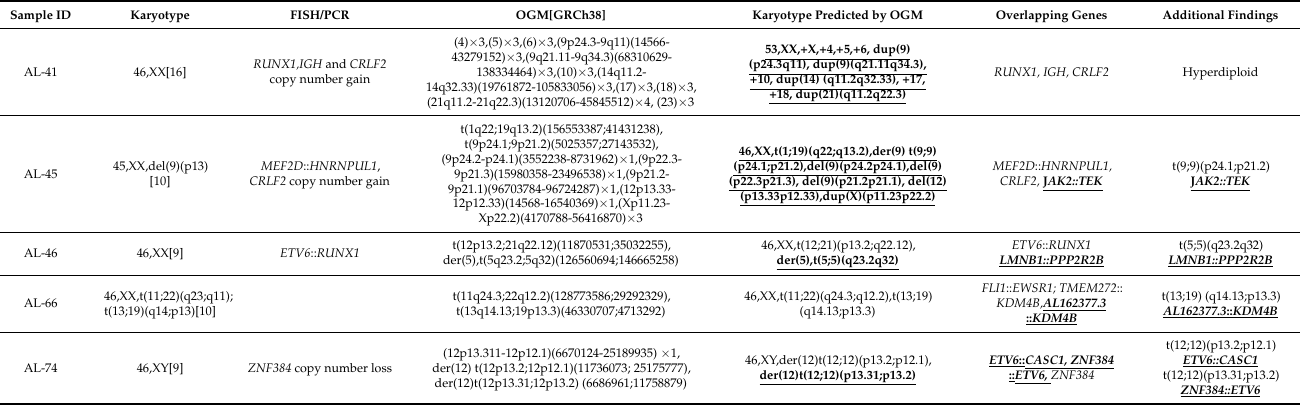
Table 2. Additional SVs and CNVs, Identified by OGM but not by Conventional